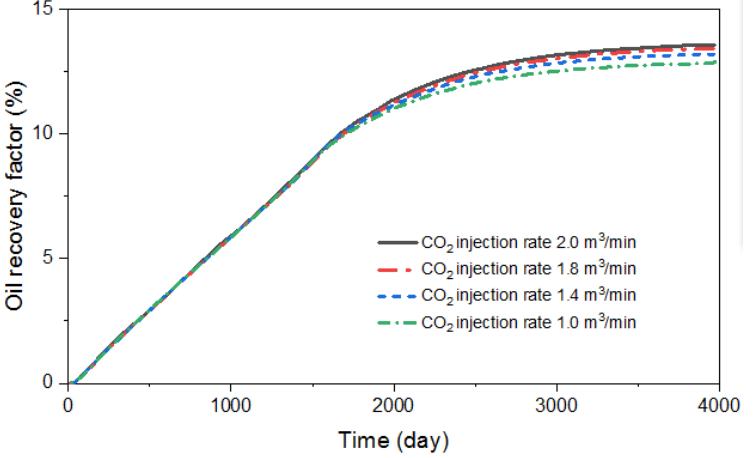
Figure 10. The comparison of oil recoveries under different CO 2 injection rates.